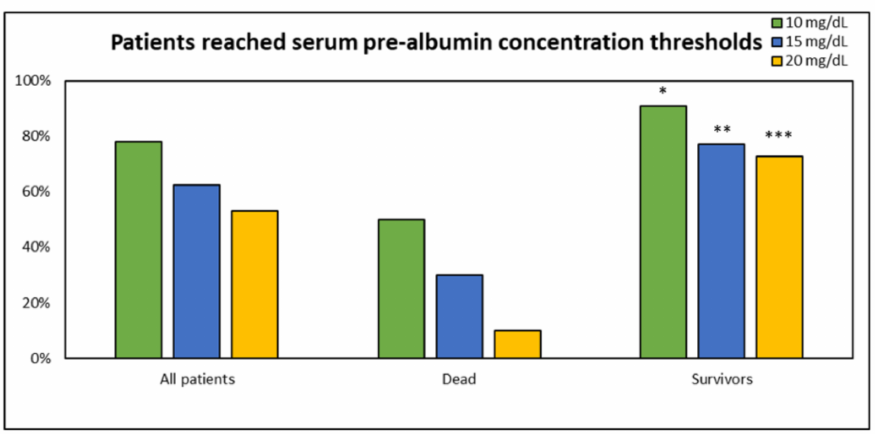
Figure 3. Percentage of patients reaching different serum pre-albumin concentration thresholds. All patients’ data are presented firstly, and then data on non-survivors and survivors. There was not statistical difference between percentages of patients reaching different PT ( p = NS). A significantly lower percentage of non-survivors was able to reach the considered pre-albumin thresholds vs.